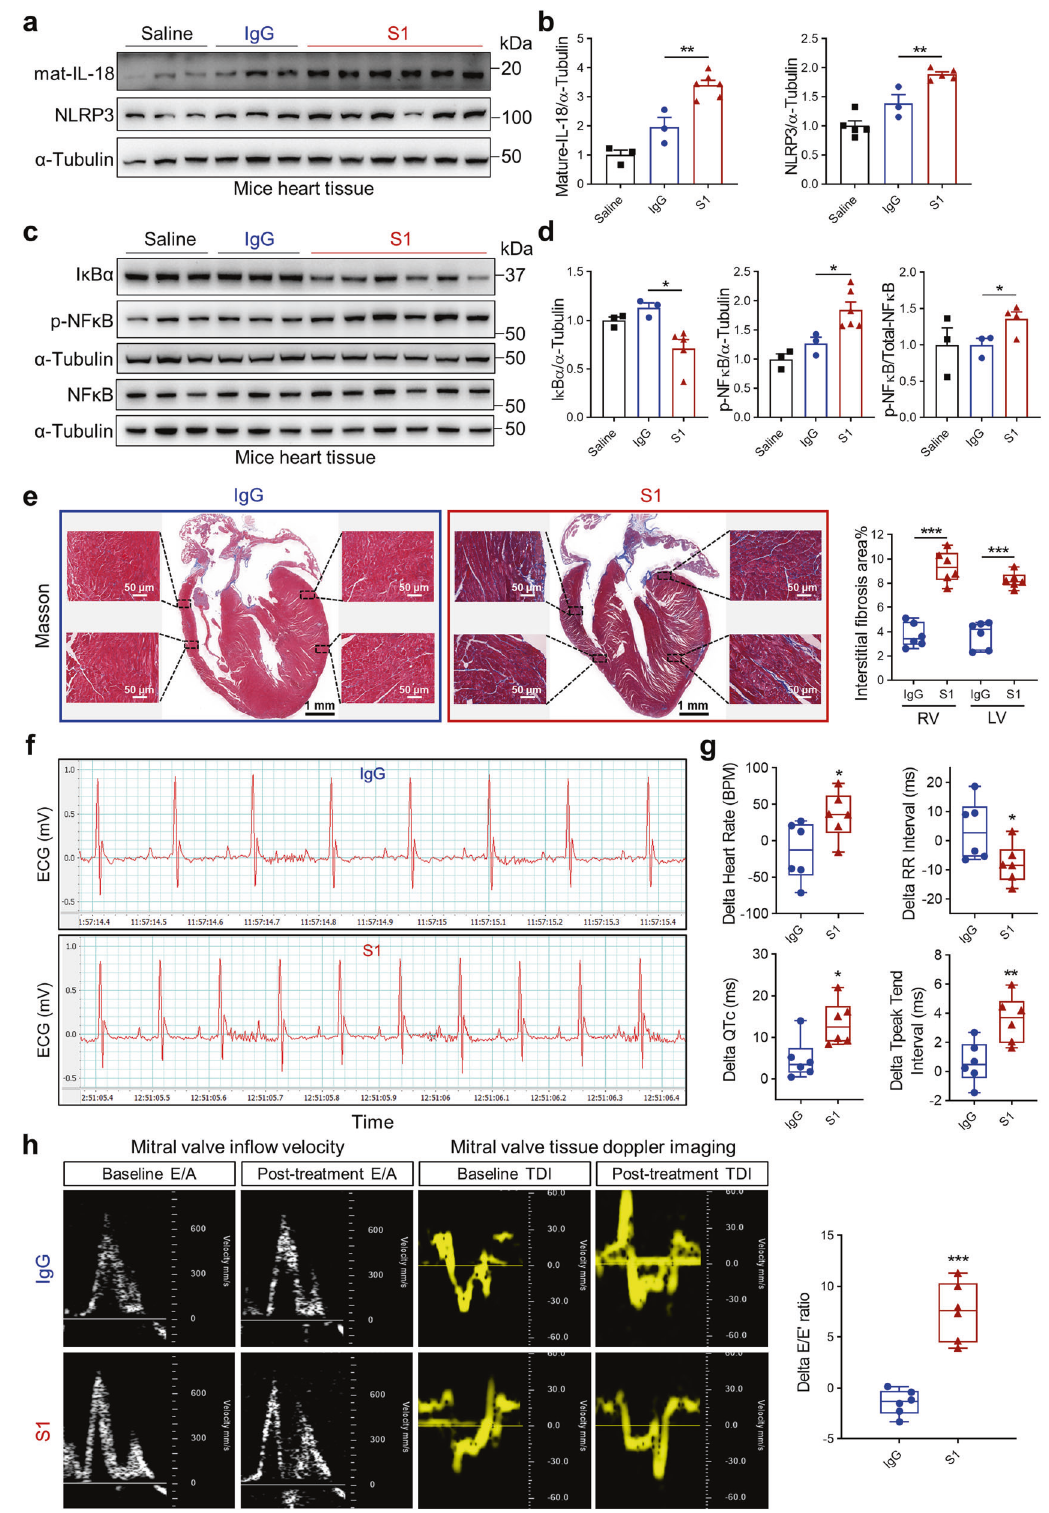
Fig. 3 Spike 1 protein induces cardiac IL-18 expression, fi brosis, and heart dysfunction in hACE2-KI mice. a , b Western blots of IL-18 and NLRP3 levels in heart tissues. Quantitative data shown in right panel ( b ) (Student ’ s t -test, N = 3 – 5). Representative western blots showing protein levels of I κ B α , NF- κ B, phospho-NF- κ B ( c ) and summarized data ( d ) in heart tissues (Student ’ s t -test, N = 3 – 6). e Representative Masson Trichrome staining images of heart from IgG- versus S1 protein-treated mice. Fibrosis area percentage was higher in S1 protein-treated mice heart tissues (Student ’ s t -test, N = 6). f , g Heart rate, RR interval, QTc interval, Tp-Te interval were measured by electrocardiograms (ECG) in mice after S1 exposure (Student ’ s t -test, N = 6). h Representative echocardiogram images of mitral valve in fl ow velocity and tissue doppler and summarized data showing impaired diastolic function (increased delta E / E ’ ) after S1 exposure (Student ’ s t -test, N = 6). Values are mean ± SE. * p < 0.05, ** p < 0.01, *** p < 0.001 relative to IgG exposure Signal Transduction and Targeted Therapy (2023)